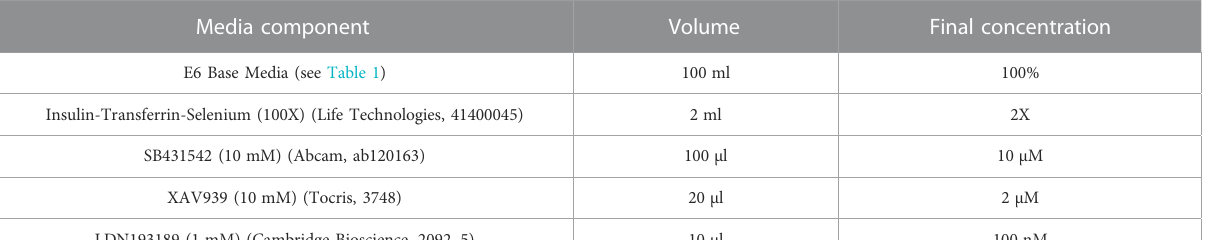
TABLE 2 Components of neural induction media.